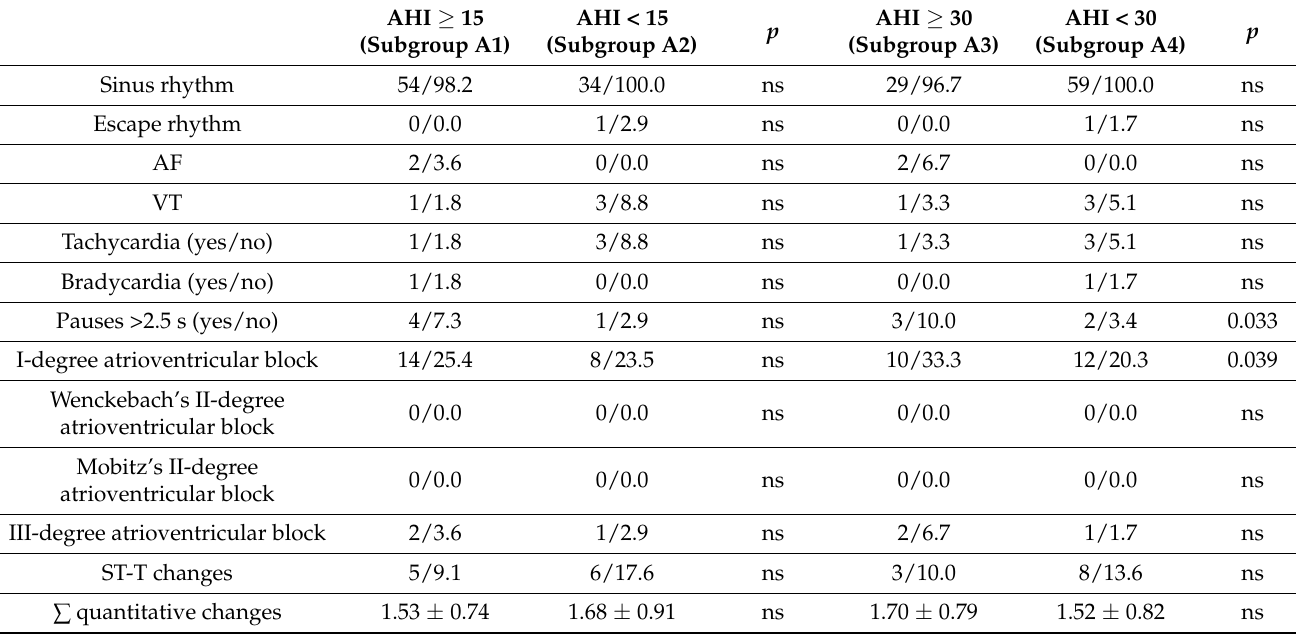
Table 5. Qualitative parameters of 24-h ECG Holter monitoring in the studied subgroups of patients divided by apnea- hypopnea index (AHI) threshold values.